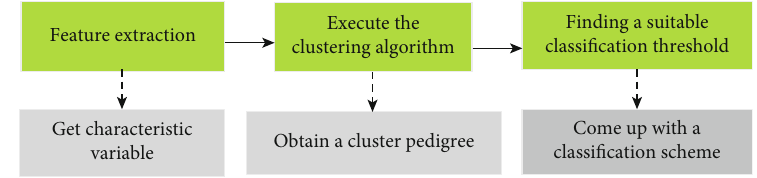
Figure 3: Clustering algorithm